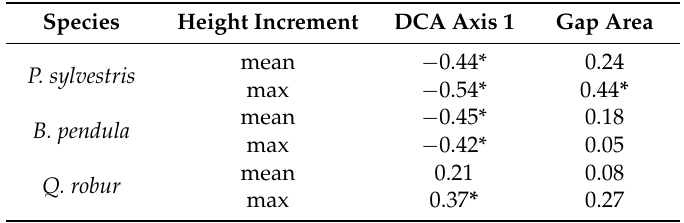
Table 3. Pearson’s correlation of mean and maximum sapling height increment to DCA axis 1 scores and gap area. Maximum height increment refers to the highest mean increment of a seedling of sampling in a plot.